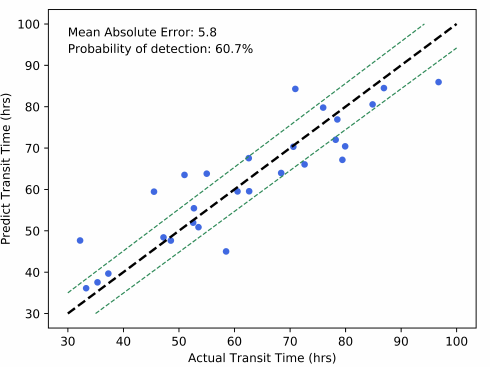
Figure 9. The relationship between the predicted transit time and the actual transit time of our method on the testing set.